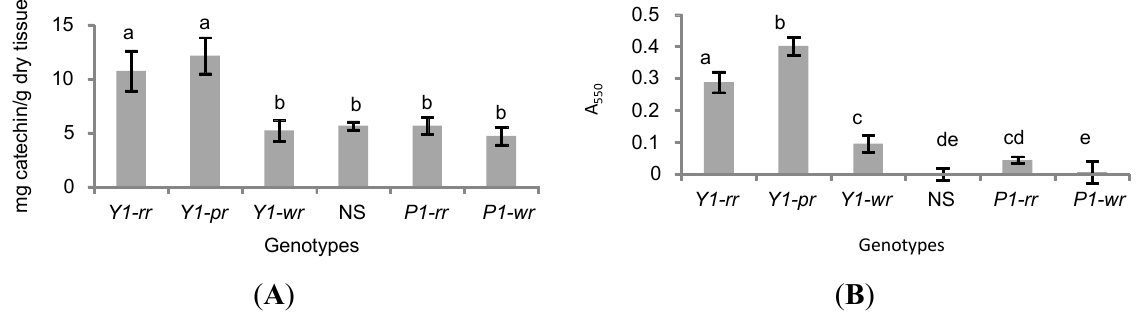
Figure 3. Sorghum y1 gene induces accumulation of flavonoid compounds in transgenic maize leaves. Y1-rr , Y1-pr , and Y1-wr are independent transgenic events; NS, Negative segregant; P1-rr and P1-wr , maize lines carrying endogenous p1 alleles. Values shown are mean ± SE. ( A ) Total flavonoids expressed as catechin equivalents; ( B ) Flavan-4-ols expressed as absorbance at 550